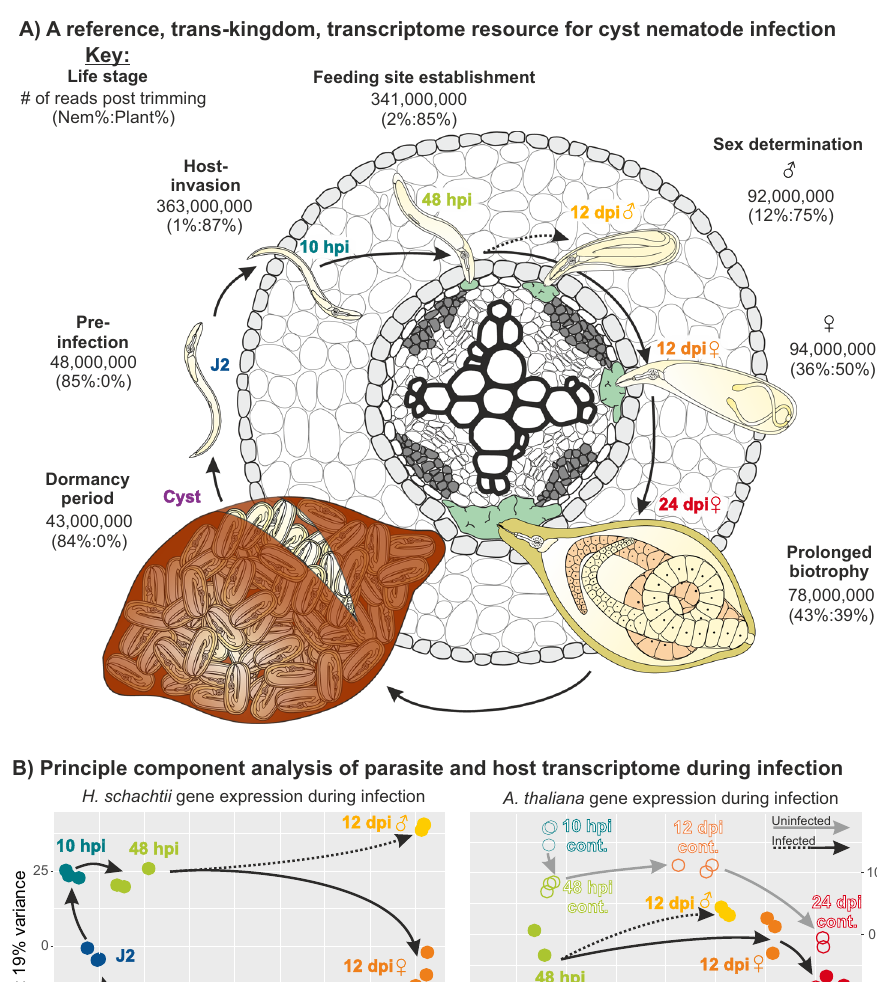
Fig. 1 | Trans-kingdom, lifestage-speci fi c, transcriptome of H. schachtii and A. thaliana . A Schematic representation of the life cycle of H. schachtii infecting A. thaliana , highlighting the 7 stages sampled in this study. For each stage, the average number of trimmed RNAseq read pairs per replicate is shown, with the